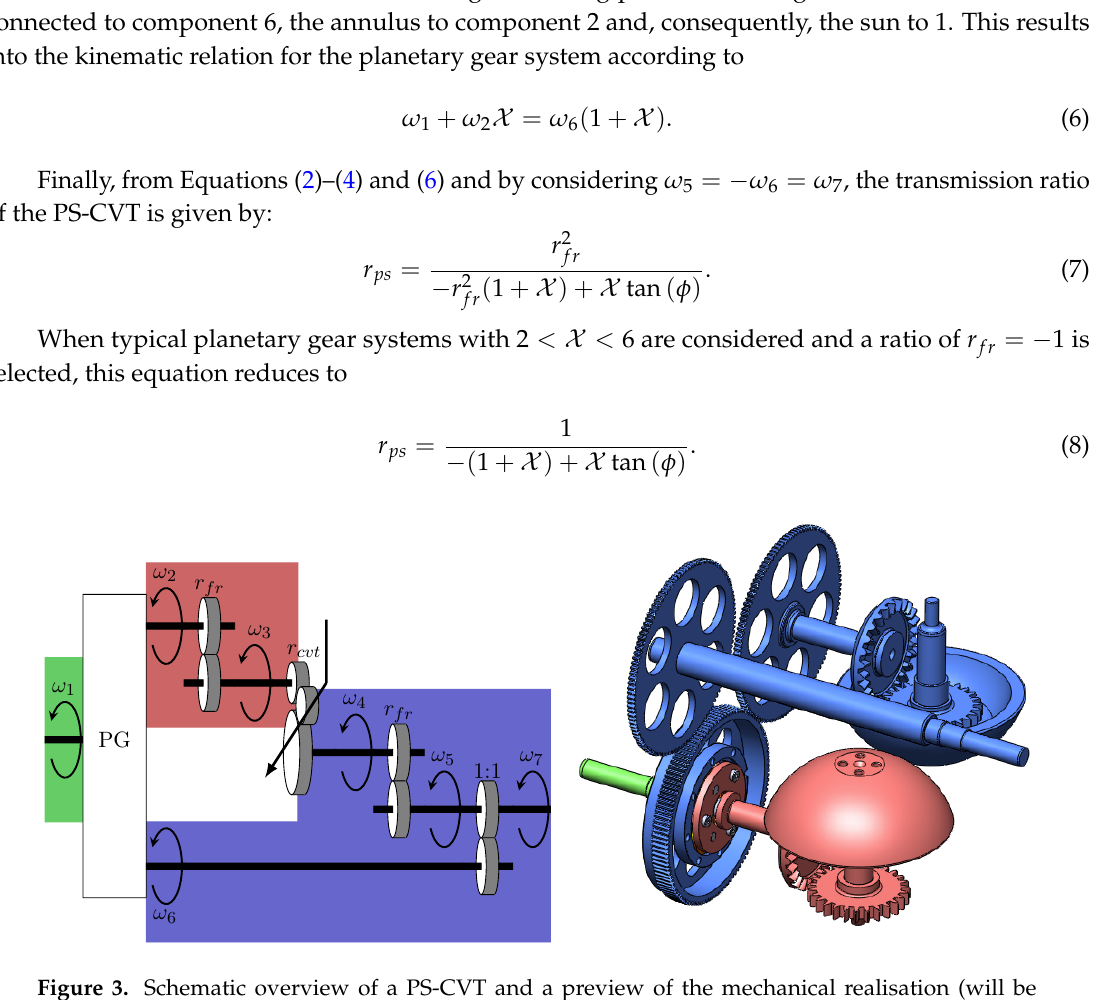
Figure 3. Schematic overview of a PS-CVT and a preview of the mechanical realisation (will be discussed in depth in Section 5). The colour coding illustrates the relation between parts in the schematic figure the drawing of the mechanical system. The parts connected to the ring gear of the planetary gear are blue, the parts connected to the cage of the planets of the planetary gear are coloured red and the parts connected to the sun gear of the planetary gear are coloured green. ( a ) Schematic overview of a PS-CVT. ( b ) Drawing of the mechanical